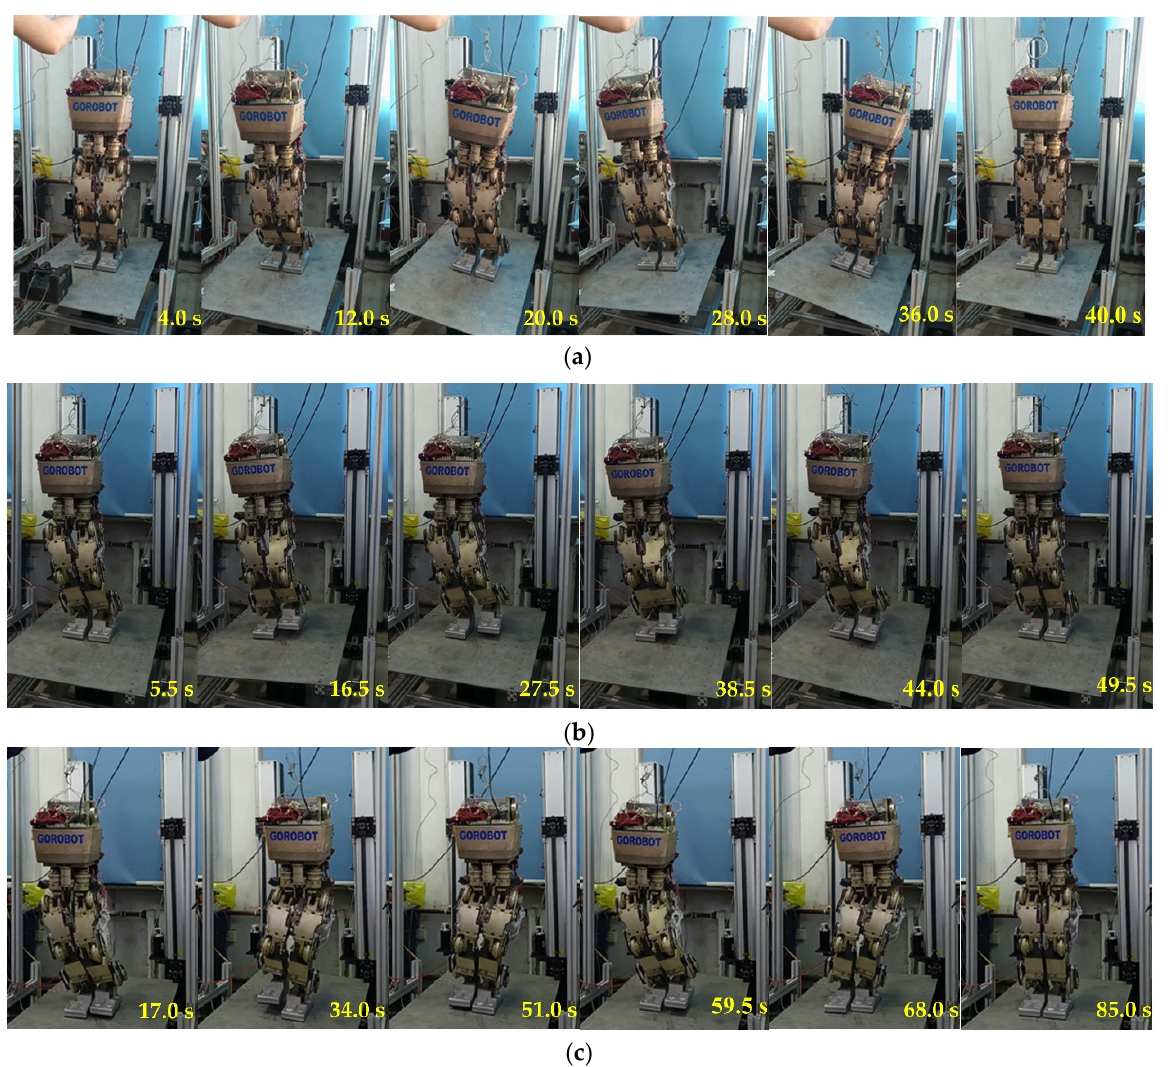
Figure 19. ZMP curves in three experiments. ( a ) Double-leg stance; ( b ) single-leg stance; ( c ) stepping.